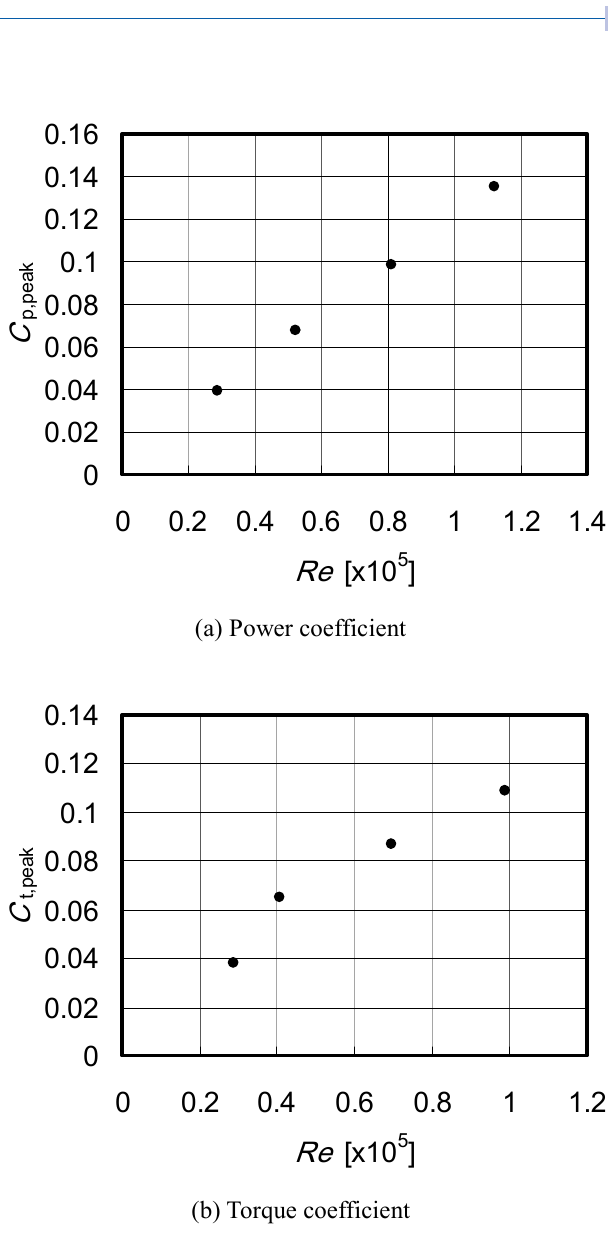
Fig. 6 Effect of Reynolds number on turbine characteristics ( σ = 1.37, α = 30º)